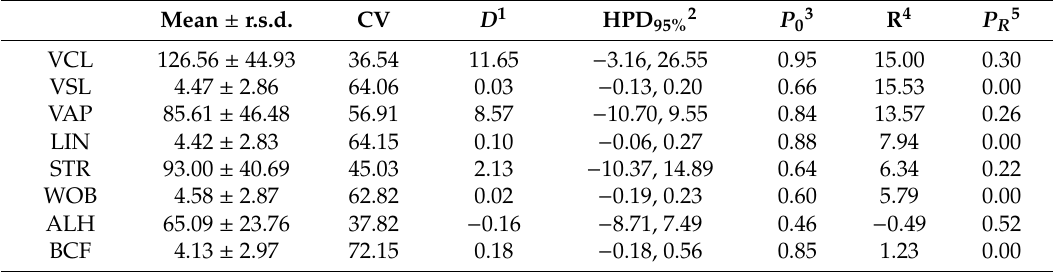
1 D : mean of the marginal posterior distribution of the di ff erence B t -B i , where B t is Bos taurus and B i is Bos indicus ; ff erence being greater than zero when D 2 HPD 3 P 95% , highest posterior density region at 95%; 0 , probability of the di > 0 and probability of the di ff erence being lower than zero when D < 0; 4 R, relevant value estimated as 1 / 3 standard deviation; 5 P R , probability of the di ff erence being greater than R when D > 0 and less than R when D < 0. Number of cells = 6493. r.s.d.: residual standard deviation. CV: coe ffi cient of variation (%). VCL = curvilinear velocity